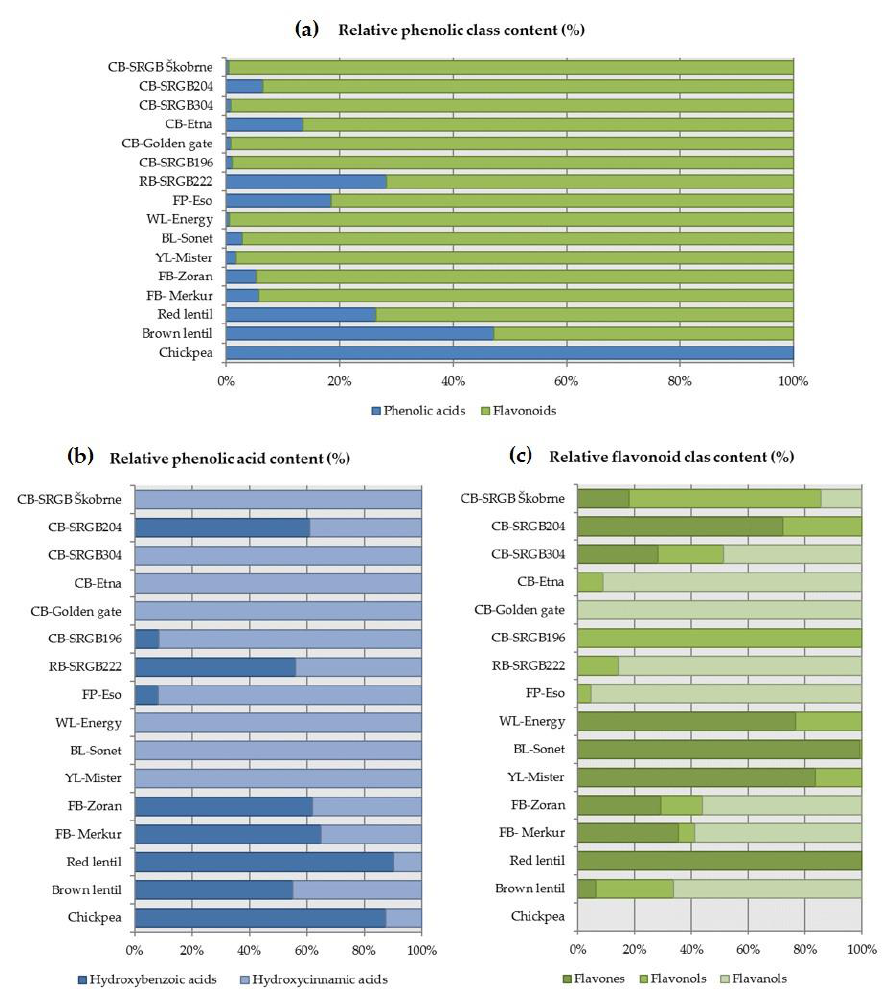
Figure 2. Principal qualitative profiles of phenolic classes ( a ), phenolic acid classes ( b ), and flavonoid classes ( c ) in seeds of 16 pulse samples. CB, common bean; RB, runner bean; FP, field pea; WL, white lupin; BL, blue lupin; YL, yellow lupin; FB, faba bean.